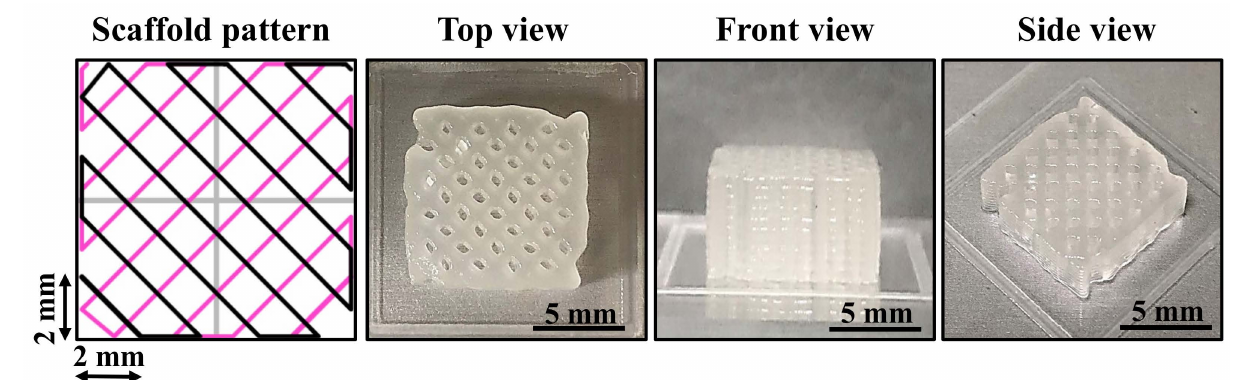
Figure 7. Measuring wire diameter by filament fusion testing (*** p < 0.001).